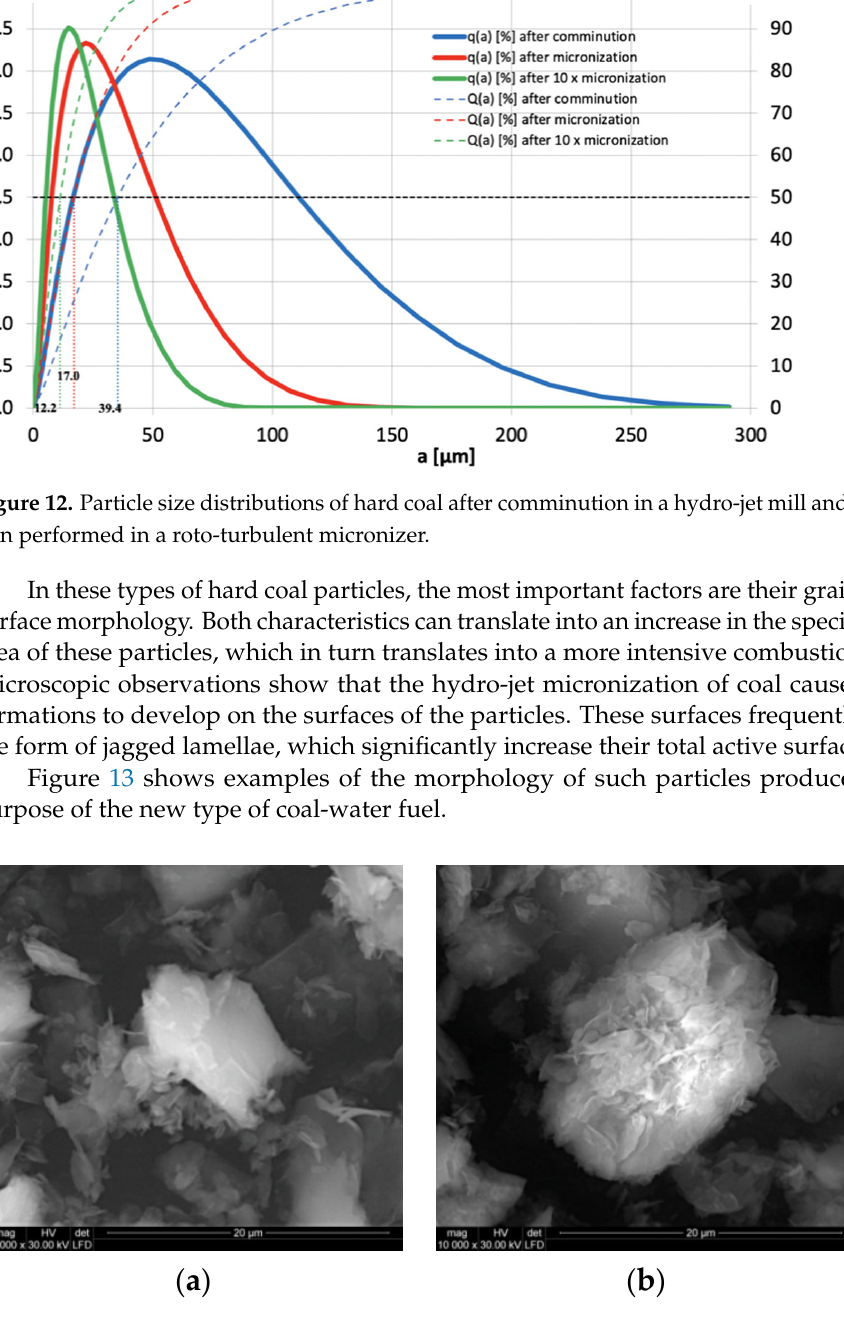
Figure 13. Examples of SEM images of micronized hard coal particles with different degrees of surface development: ( a ) General view of comminuted coal particles; ( b ) individual coal particle showing out its lamellar structure.